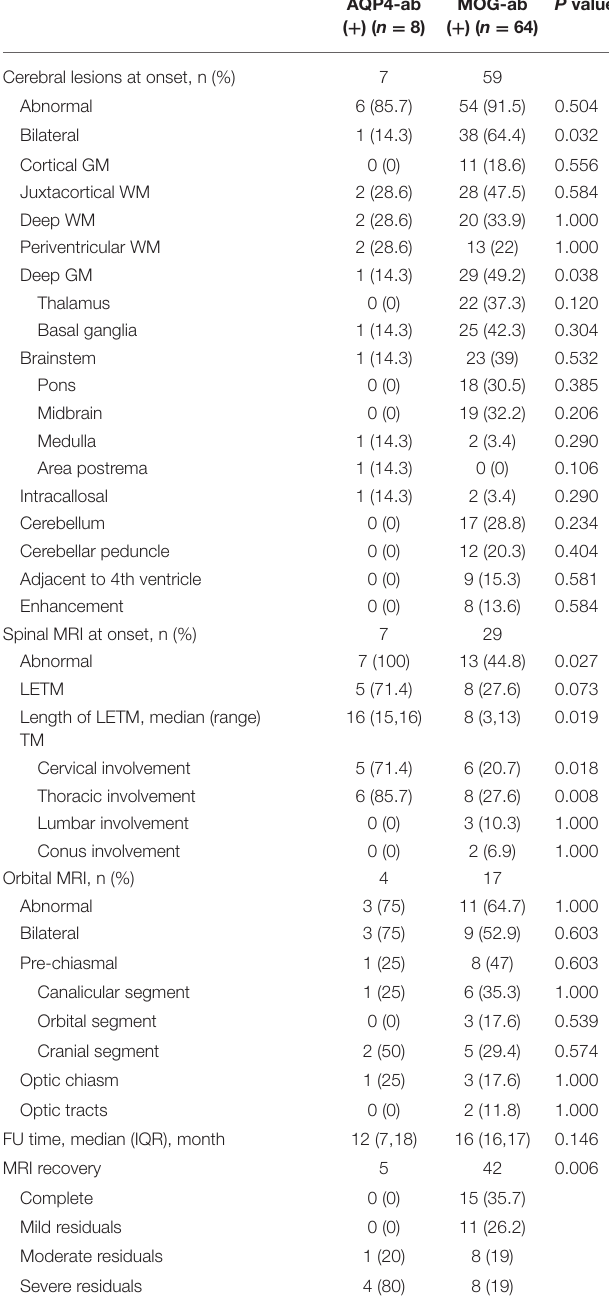
TABLE 3 | Comparison of radiologic features in AQP4-ab-positive and MOG-ab-positive